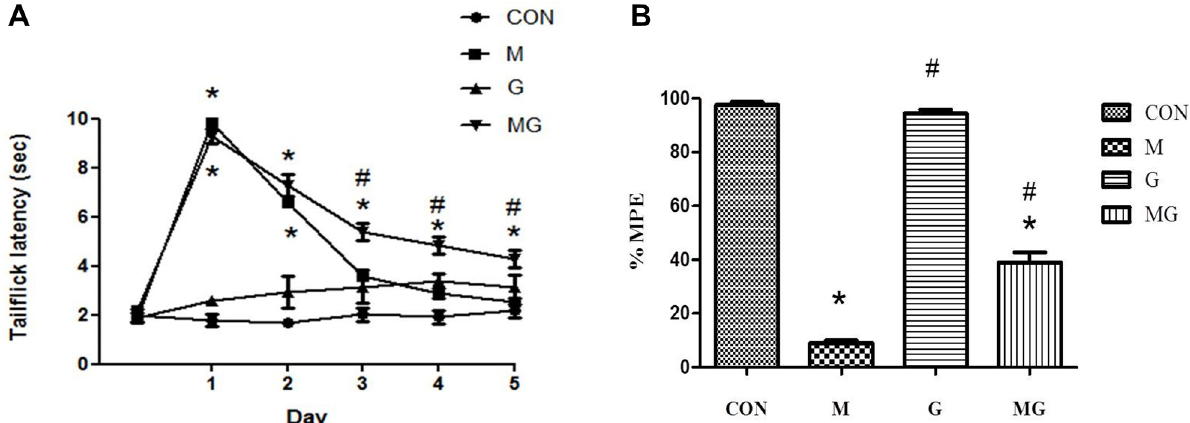
Fig 3. Anti-nociceptive effects of intrathecal co-infusion of morphine and gabapentin in chronic morphine-infused rats. The denotation * ( P < 0.05) is the comparison to the control group and # ( P < 0.05) is the comparison to the morphine-infused group. (A) Time course of tail-flick latencies over the 5-day period of i.t. infusion of saline or morphine with/without gabapentin. CON: saline (1 μ l/h) infusion (n = 10); M: morphine (15 μ g/h) infusion (n = 10); G: gabapentin (15 μ g/h) infusion (n = 10); MG: morphine (15 μ g/h) plus gabapentin (15 μ g/h) co-infusion (n = 10). All data points are expressed as mean ± SEM. Co-infusion of morphine and gabapentin attenuates morphine tolerance formation. (B) Anti-nociceptive effect of a single challenge dose of morphine administrated in the rats on day 5. A single dose of morphine (15 μ g) was administrated at 4 h after discontinuing drug infusion via mini-osmotic pump (when the basal tail-flick latencies had declined below 3s before morphine challenge in all test rats). The anti-nociceptive effect in the hot-water immersion (52°C) test was measured every 30 min for 180 min after morphine injection (15 μ g) (n = 5 in each group). The maximal anti-nociceptive effect of morphine (15 μ g) challenge in each group is expressed as the % change in the MPE compared to the saline control group (100%